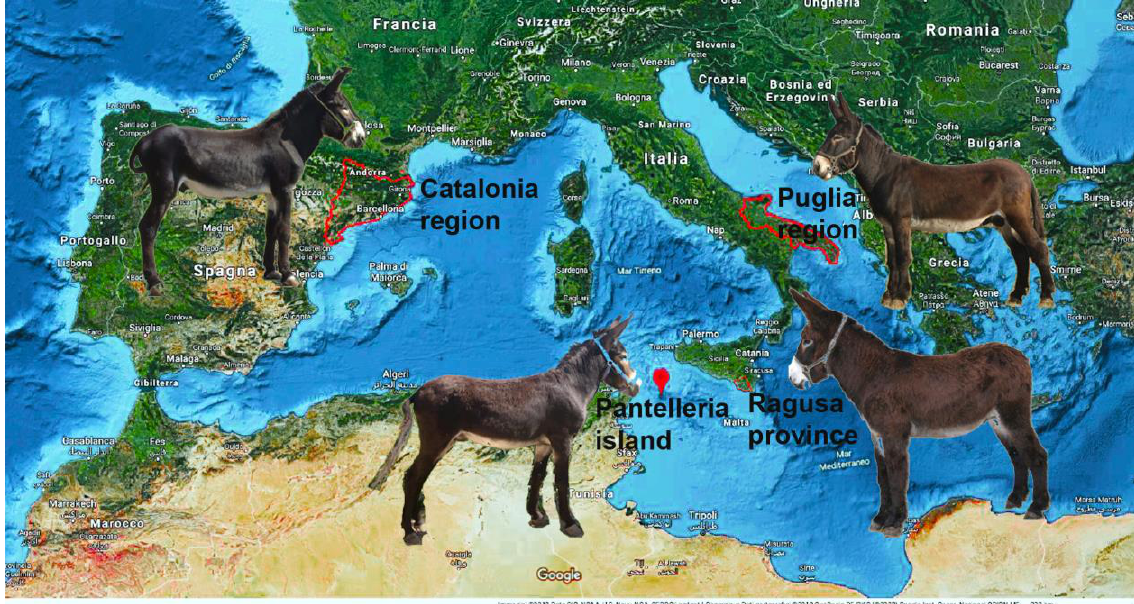
Figure 1. Breed distribution. The red perimeters pinpoint the original Mediterranean distribution of the four donkey breeds investigated: Martina Franca (MF), Ragusano (RG), Pantesco (PT), and Catalonian (CT).